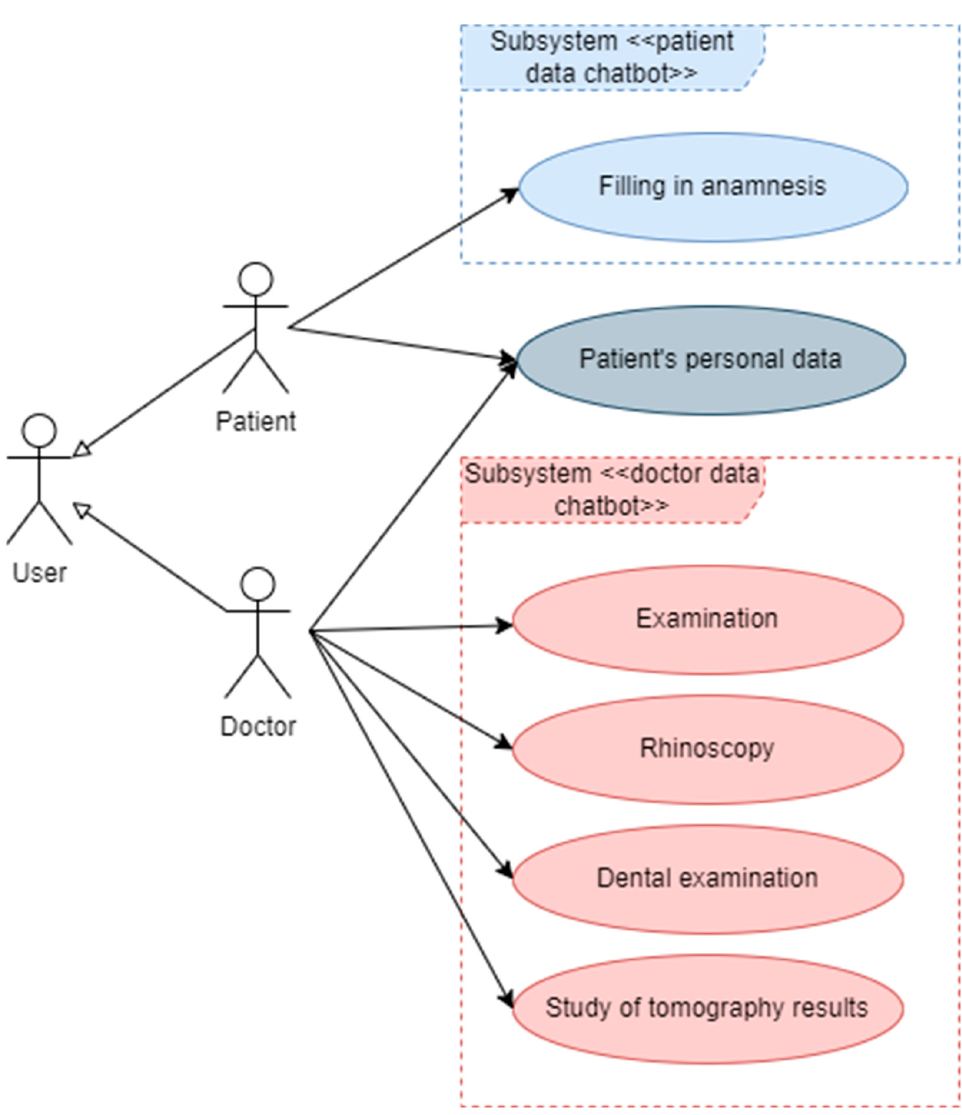
Figure 2. Intelligent chatbot use-case diagram.